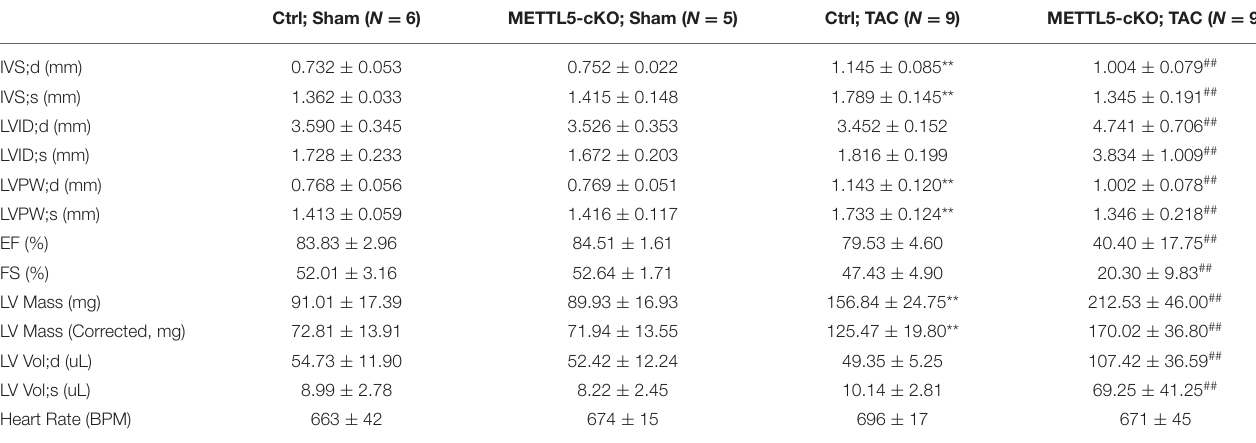
TABLE 1 | Echocardiography examination of METTl5-cKO mice and their control littermates with transverse aortic constriction (TAC) or sham operation at 4 weeks after surgery. Ctrl; Sham ( N =